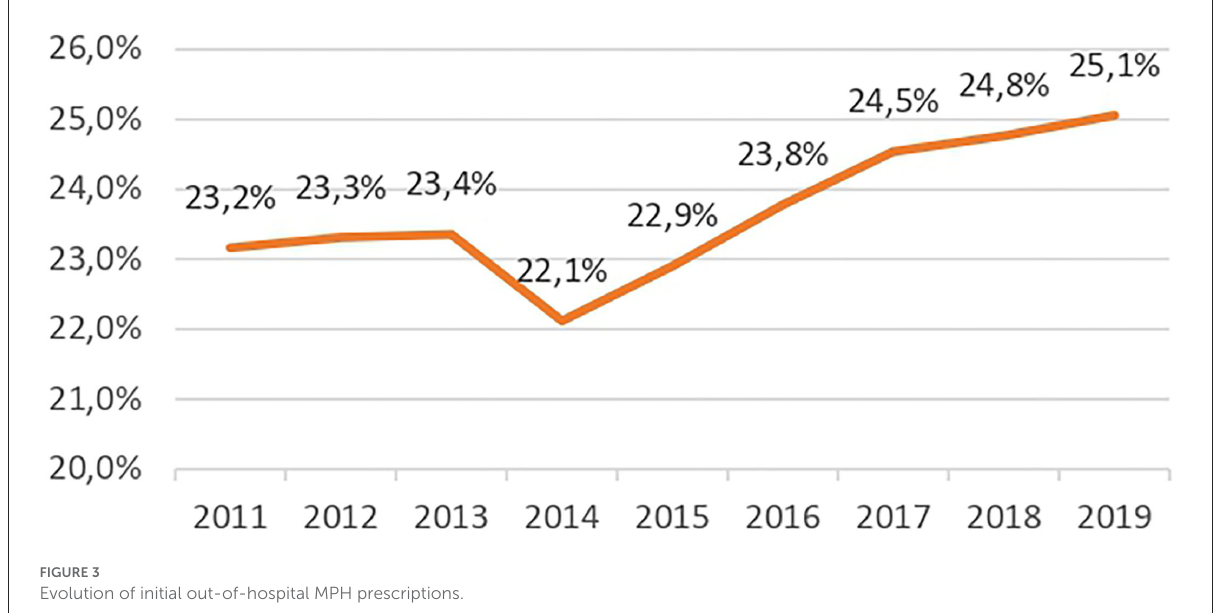
FIGURE3 Evolution of initial out-of-hospital MPH prescriptions.